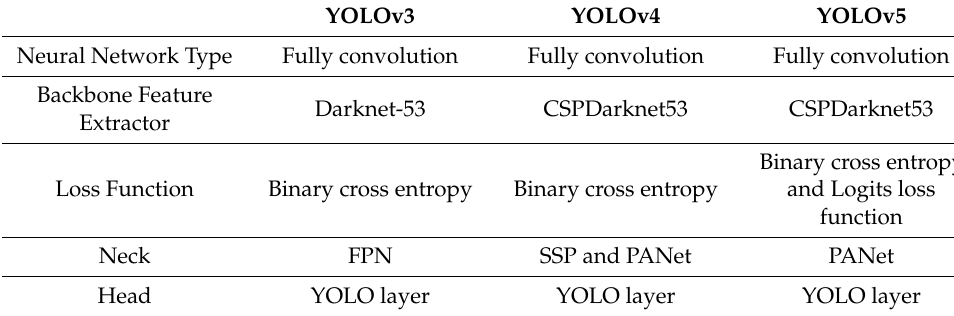
Figure 2. General Architecture of YOLO algorithm. Table 2. Comparison between structures of YOLOv3, YOLOv4 and